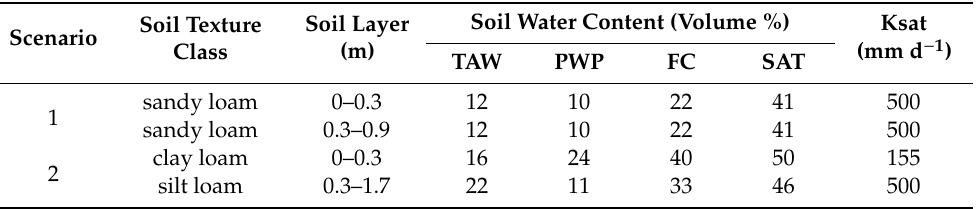
Table 1. Soil characteristics for wheat scenarios 1 and 2. Soil characteristics for scenarios 3 and 4 were the same as scenario 1. Abbreviations: TAW, total available soil water; PWP, permanent wilting point; FC, field capacity; SAT, water content at saturation; Ksat, saturated hydraulic